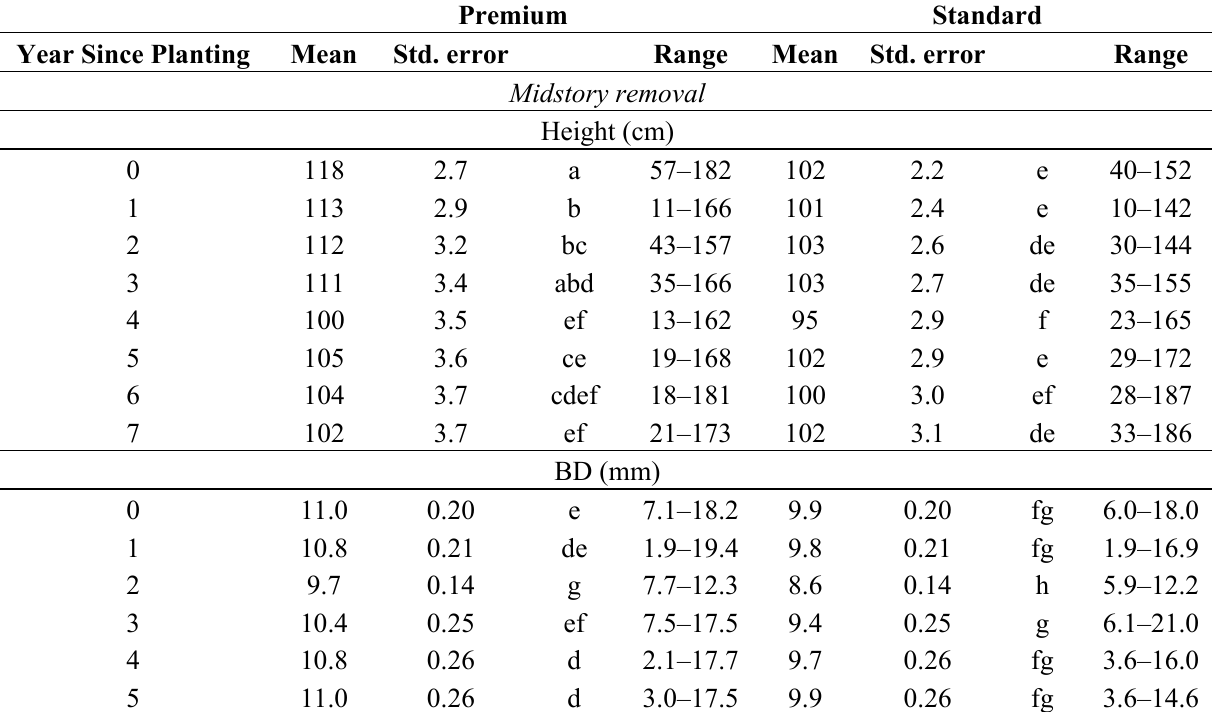
a Denominator degrees of freedom (DDF) were adjusted using the Kenward-Roger method because unequal variance was added to the model. Table 4. Least-squares means, standard errors, and ranges in total height and basal diameter (BD) for each grade in a shelterwood harvest and in a midstory-removal stand. Means followed by the same letter within each stand are not significantly